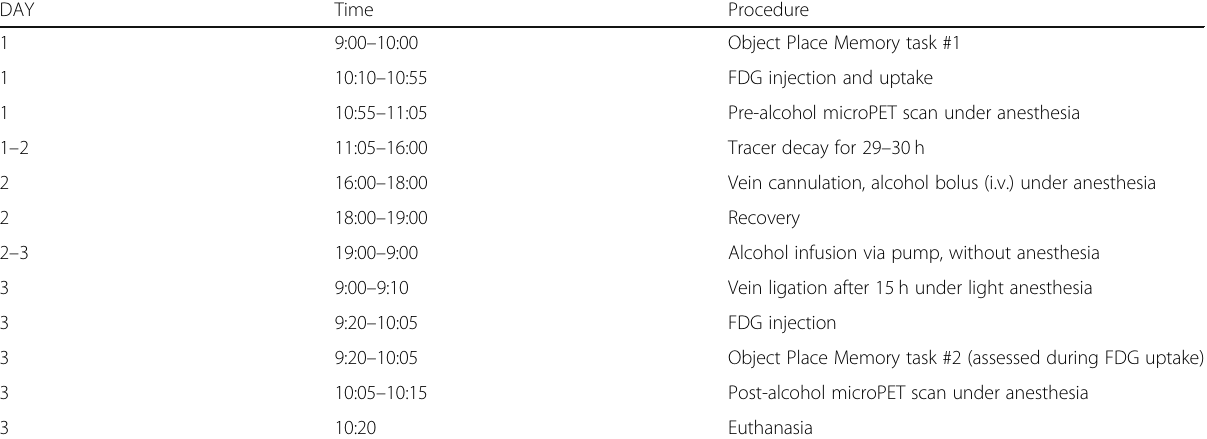
Table 1 Timeline for each experiment. Abbreviations: FDG, fluorodeoxyglucose; PET, positron emission tomography DAY